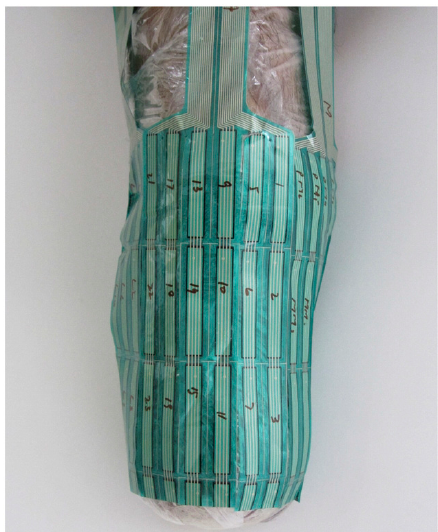
Figure 4. Four F-socket transducers covering all aspects of the residual limb to give an overall impression of pressure distribution inside transtibial prosthetic sockets [92].